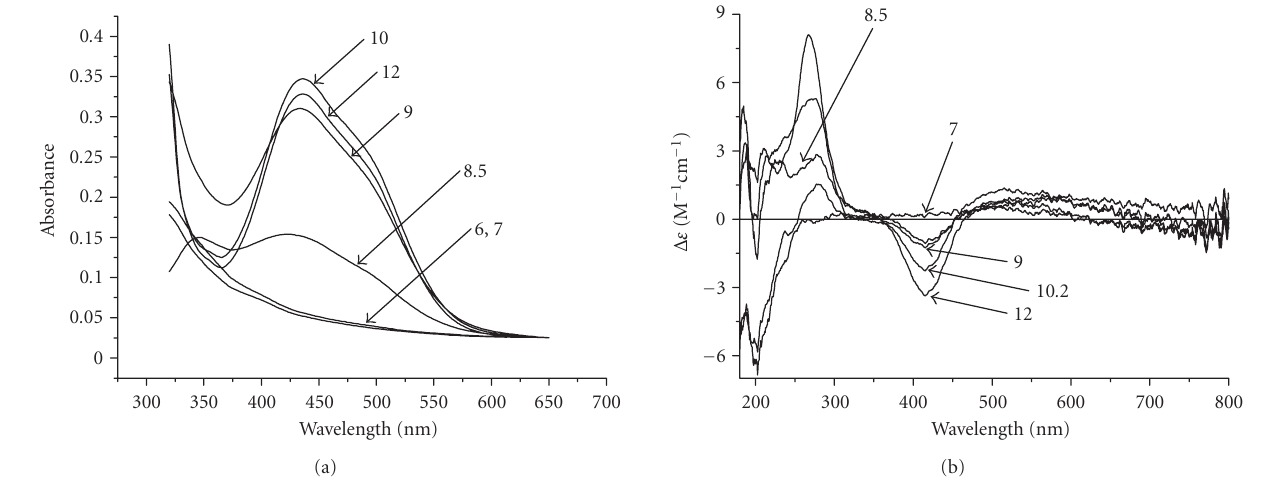
Figure 4: (a) UV/Vis and (b) CD spectra of the system Ni(II)/-LAHYNK- at various pH values.